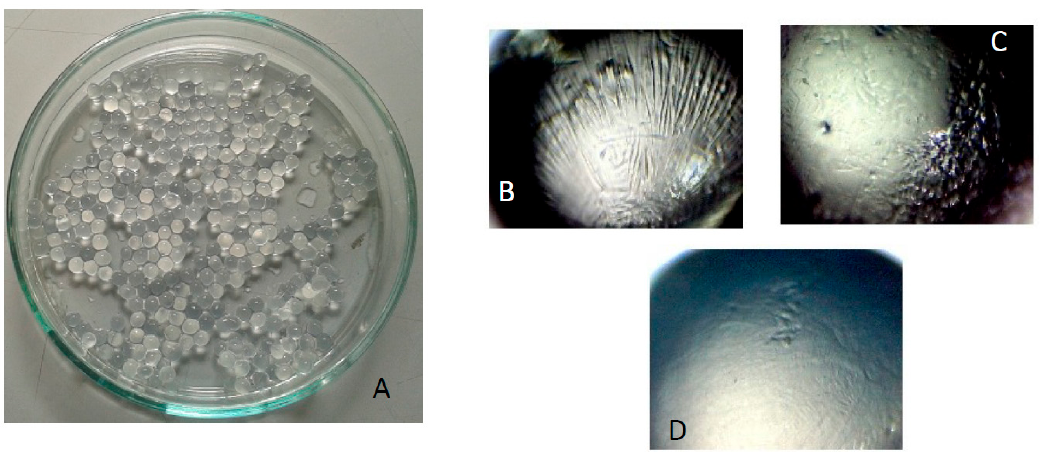
Figure 6. ( A ) Pictures of beads of GG / LAPO / Ca 0.3%; pictures of beads at the optical microscope; ( B ) GG / Ca 0.3%; ( C ) GG / Ca 0.6%; ( D ) GG / LAPO / Ca 0.3%.